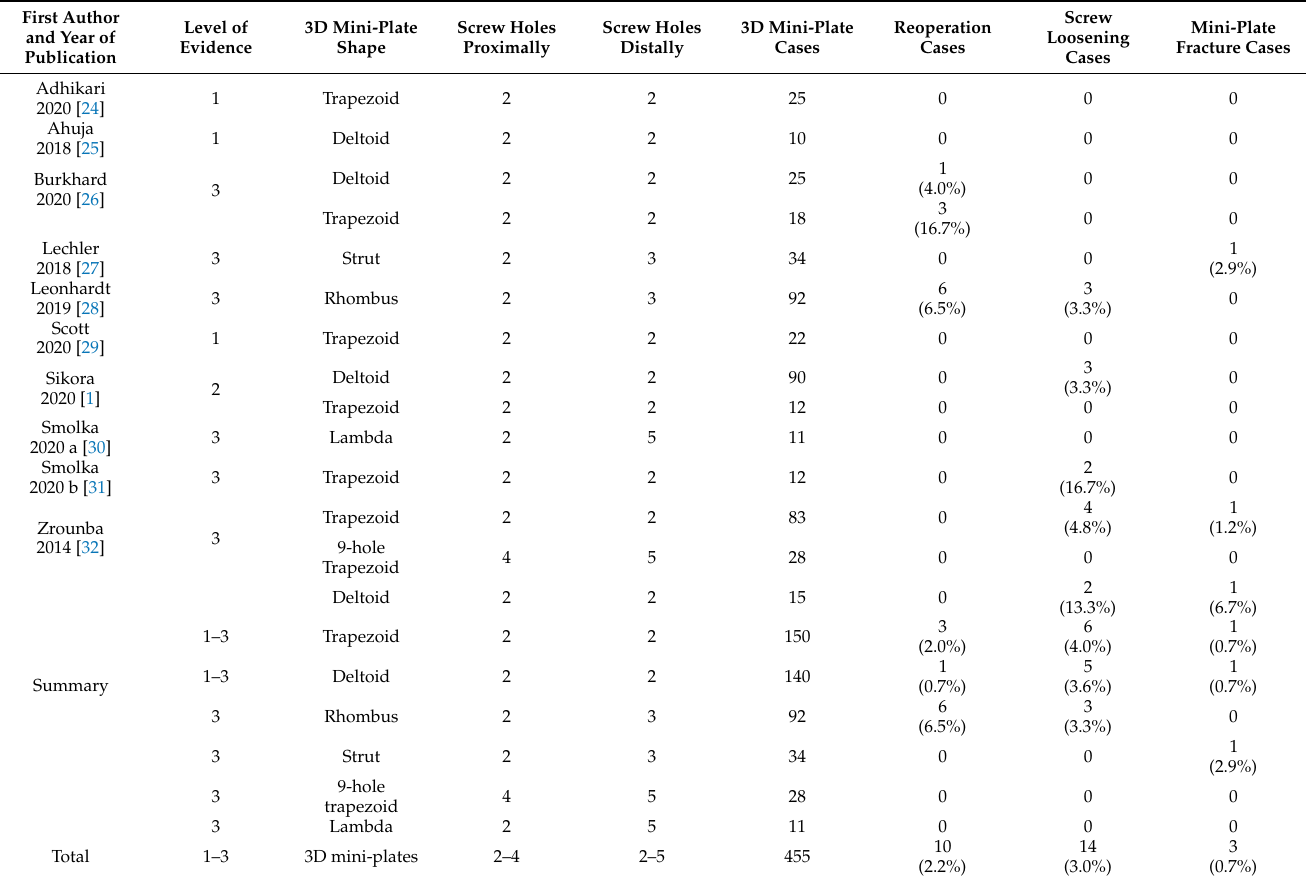
Table 4. Synthesis of data extracted from articles qualified for meta-analysis. Percentages greater than 5% and greater than 10% are